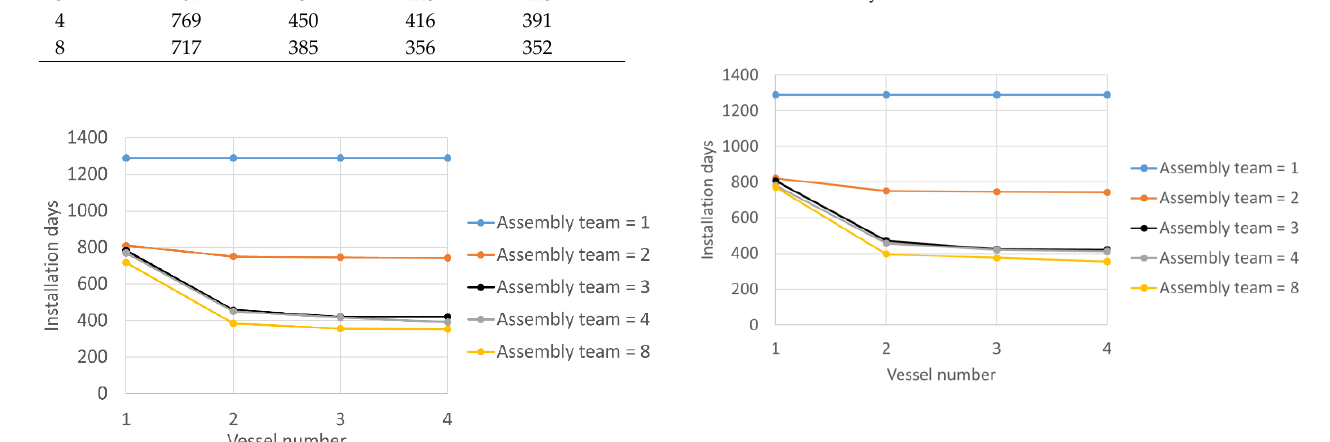
Fig. 12. Installation time against number of vessels for various numbers of assembly teams, in the case of c/d time 1.5